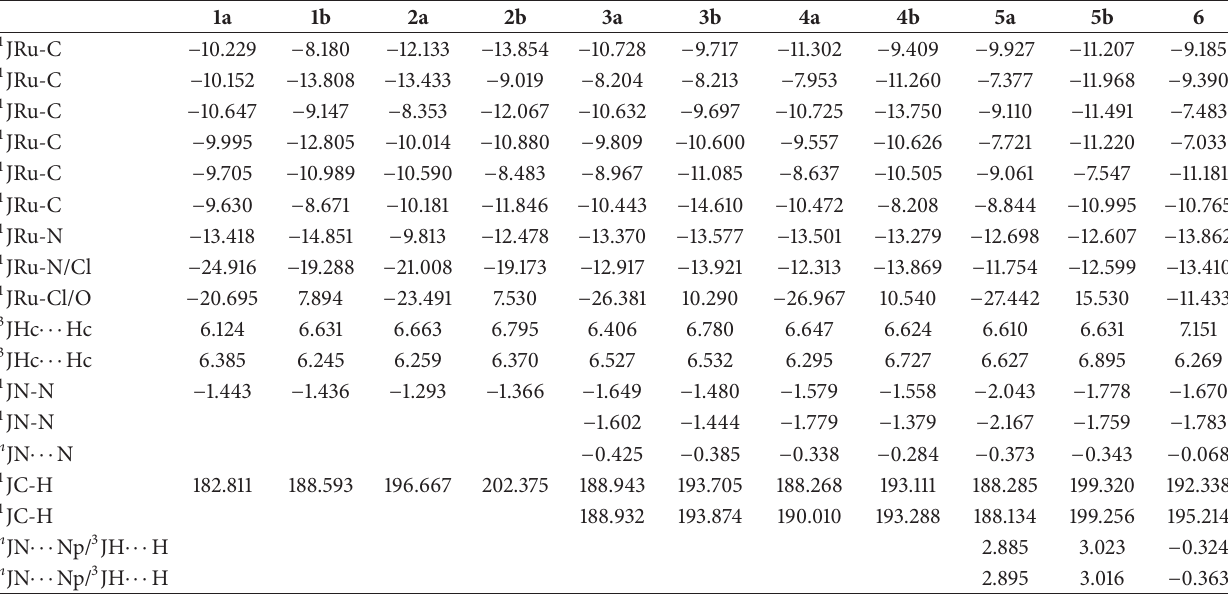
Table 5: Selected spin-spin coupling of the